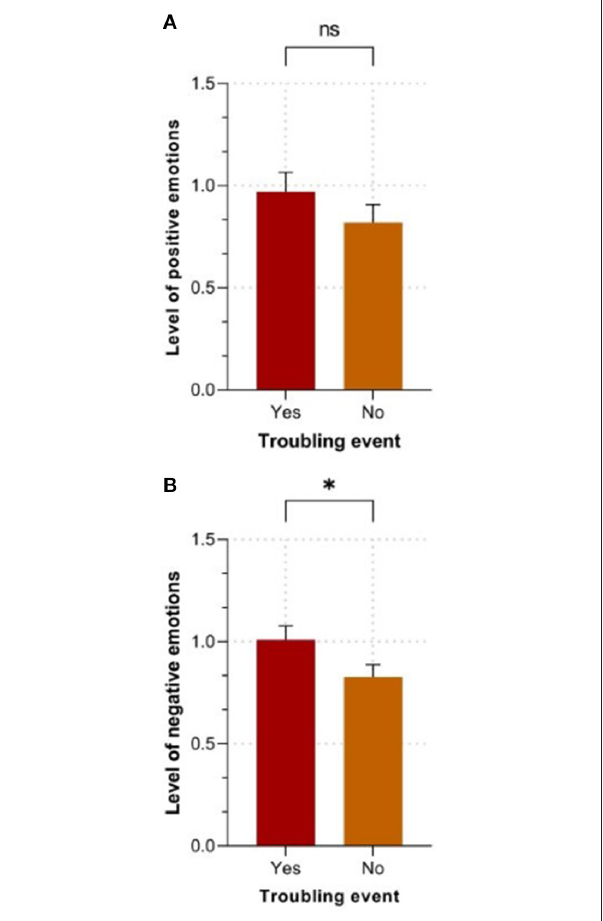
FIGURE 3 | Main effect of the experience of a recent troubling event on emotion levels in dreams. (A) . Level of positive emotions. (B) . Level of negative emotions. The values are expressed as means ± SEM, N = 253. * p < 0.05, ns = p > 0.05.